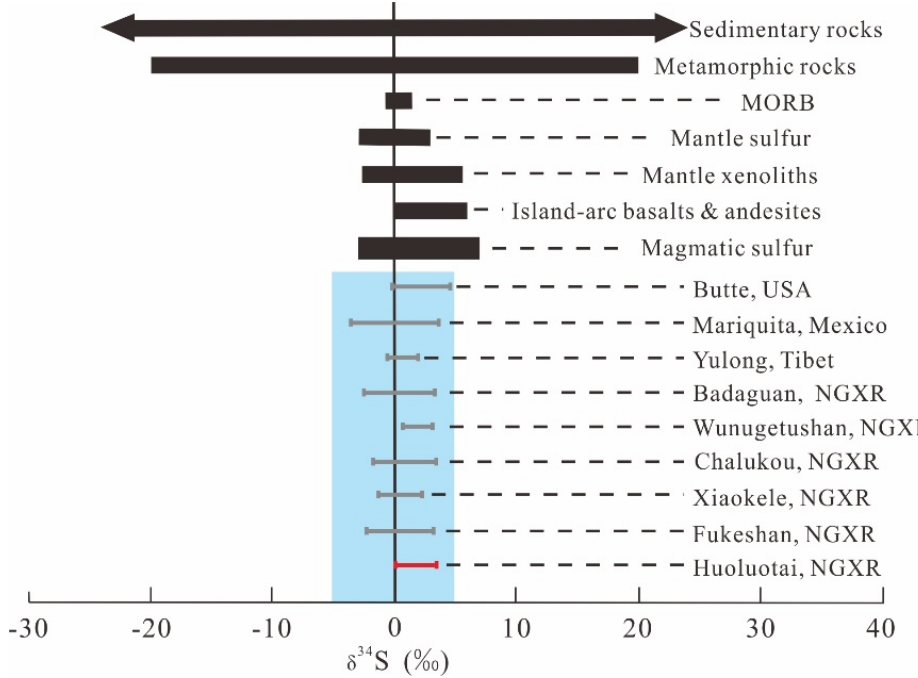
Figure 10. S isotope compositions of sulfides from the Huoluotai Cu (Mo) deposit, important S reservoirs [38–40], and other typical porphyry deposits elsewhere in the world [4,5,41–46]. The Pb isotope compositions of the four sulfide samples from the Huoluotai Cu (Mo) deposit are listed in Table 5 and illustrated in Figure 11. Here, the Pb isotope compositions of sulfides have a limited variation in 206 Pb/ 204 Pb, 207 Pb/ 204 Pb, and 208 Pb/ 204 Pb, varying from 18.352 to 18.435, 15.552 to 15.578, and 38.212 to 38.309, respectively. Table 5. Pb isotope data of sulfide samples from the Huoluotai Cu (Mo) deposit. Sample No.